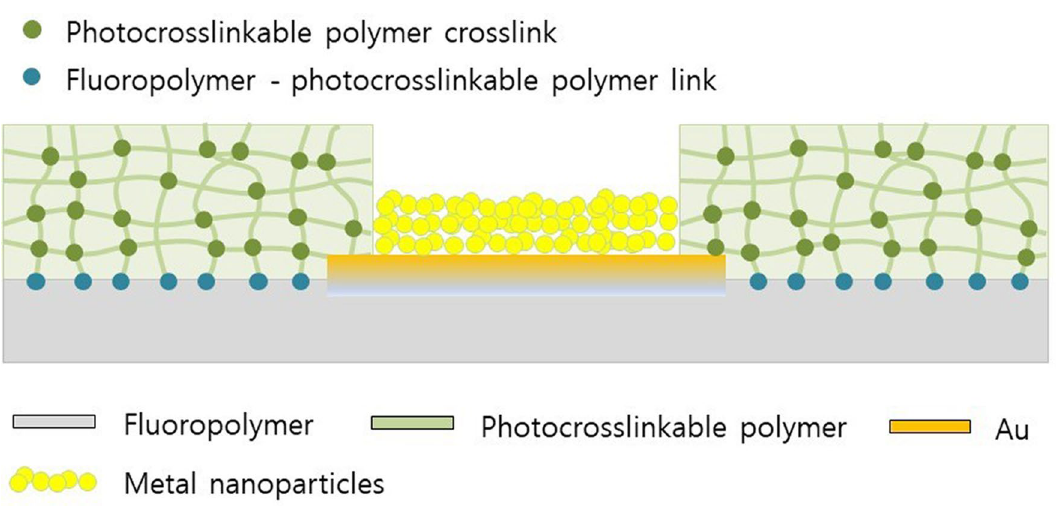
Figure 1. Schematic representation of the P&P electrode passivation process based on a photocrosslinkable polymer and plasma-treated fluoropolymer composite